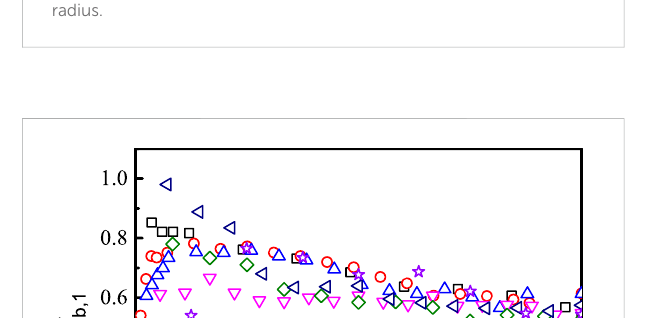
FIGURE 10 The pro fi le of ratio r d /r b,1 under different pressures.